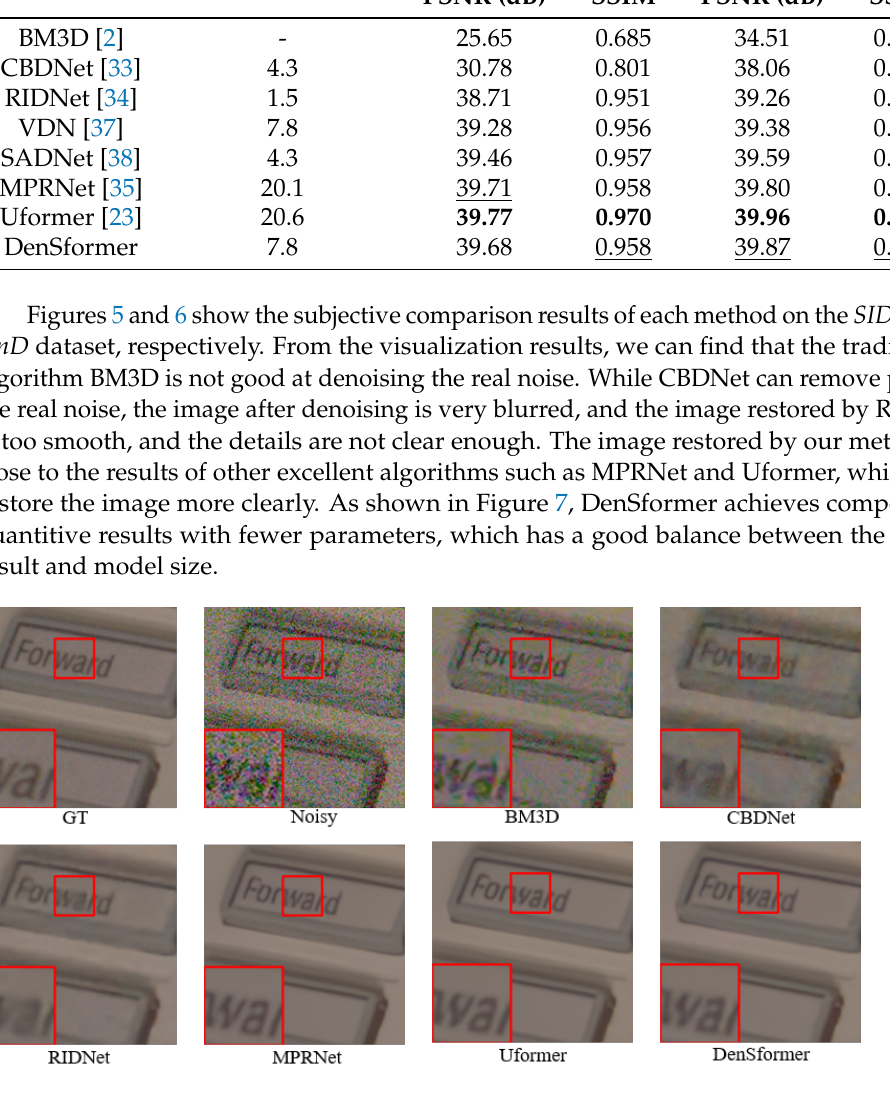
Figure 5. Denoising results of different existing methods from SIDD